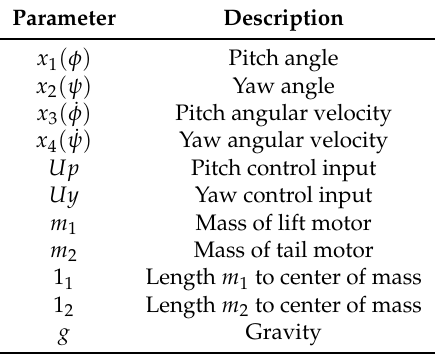
Table 1. Parameters used in the